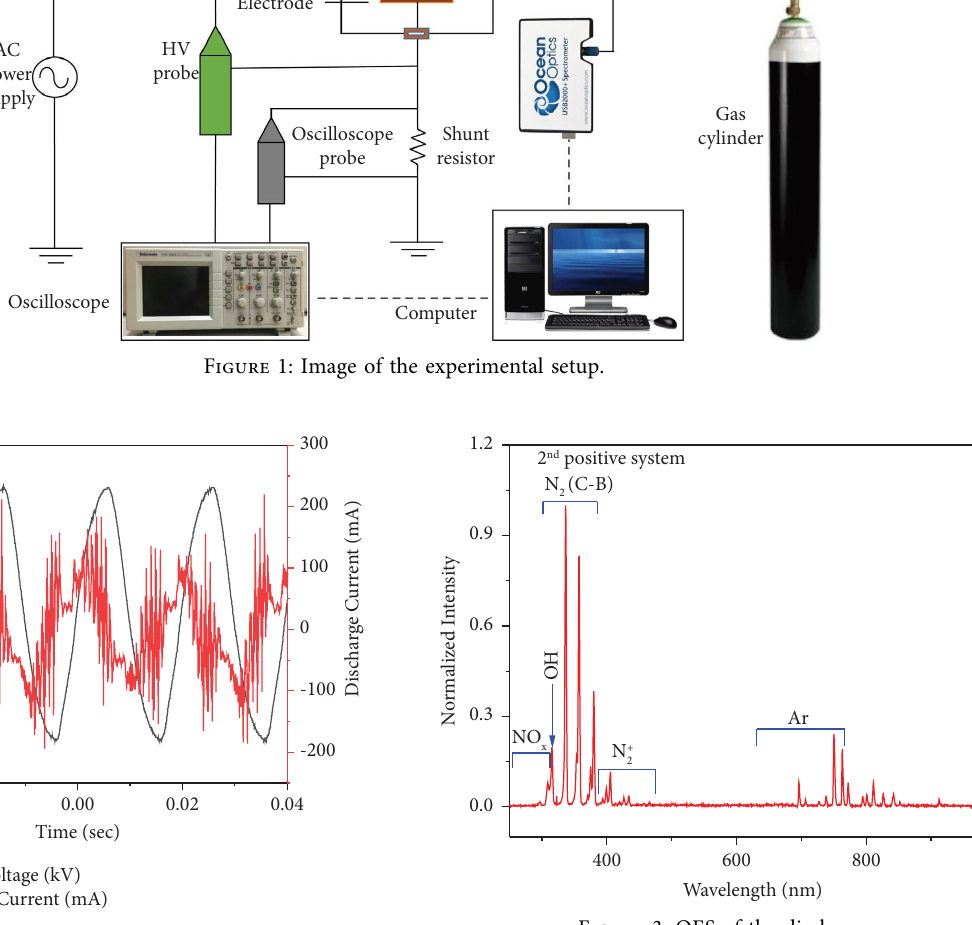
Figure 2: I ( t )– V ( t ) signal of the DBD argon plasma. Figure 3: OES of the discharge.